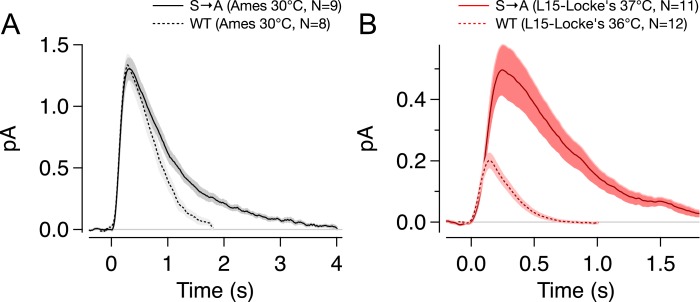
Effect of experimental conditions on S → A responses.Previous work has demonstrated a large effect of tissue storage conditions on response amplitude and kinetics. This effect accounts for the less dramatic differences between WT and S → A responses than in previous work by Mendez et al. (A) Storage and recording S → A (solid) or WT (dotted) rods in Ames medium resulted in larger and slower SPRs. (B) When retina was stored in L-15 and recording carried out in Locke's medium (solid red), dim flash responses were smaller, yet the differences between strains were accentuated. WT responses in L-15/Locke's conditions (dotted red) from Azevedo and Rieke (2011).